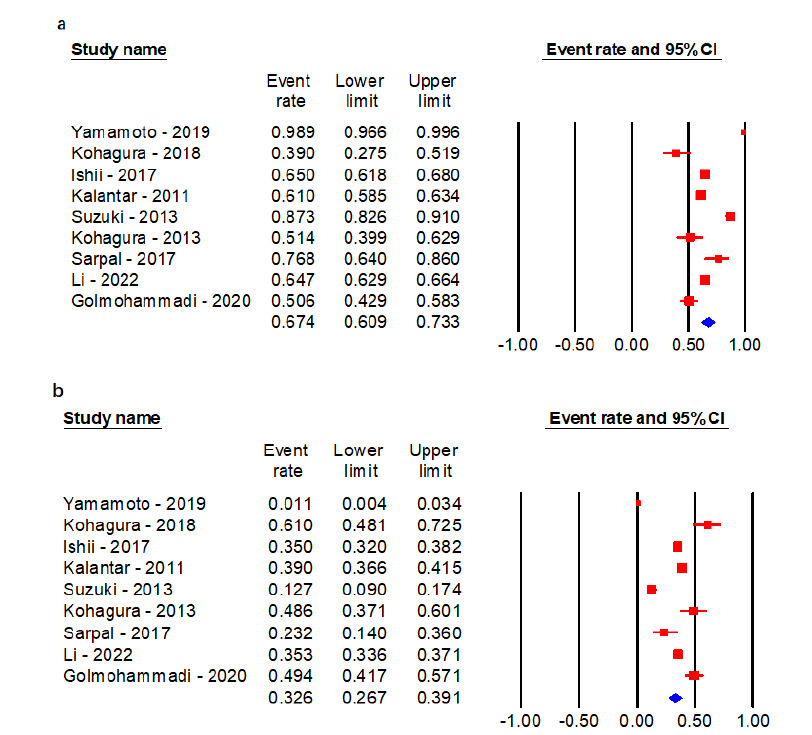
Figure 4. Gender specific prevalence of hyperuricemia in CKD patients. (a) Males; (b) females Publication